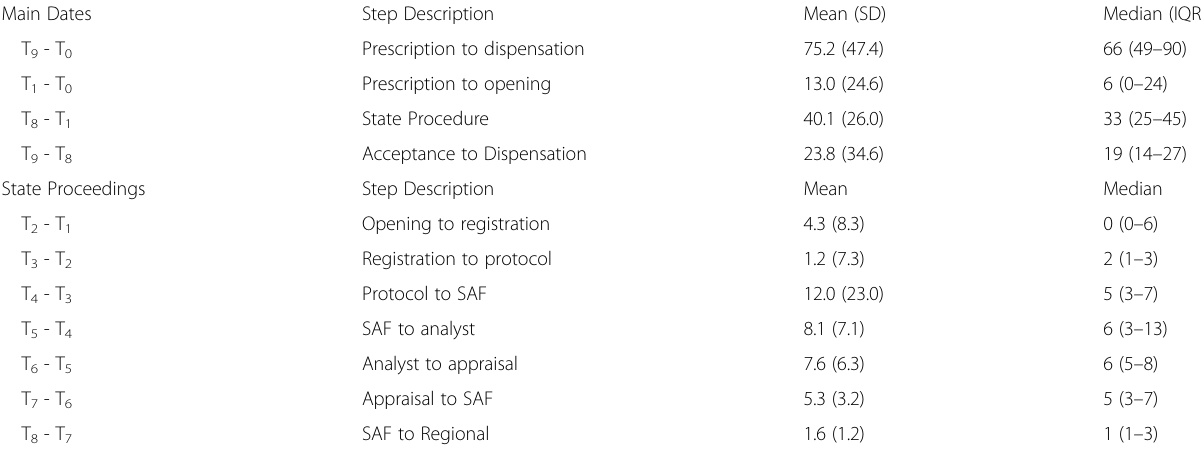
Table 2 Mean and median time between the request and the treatment starts